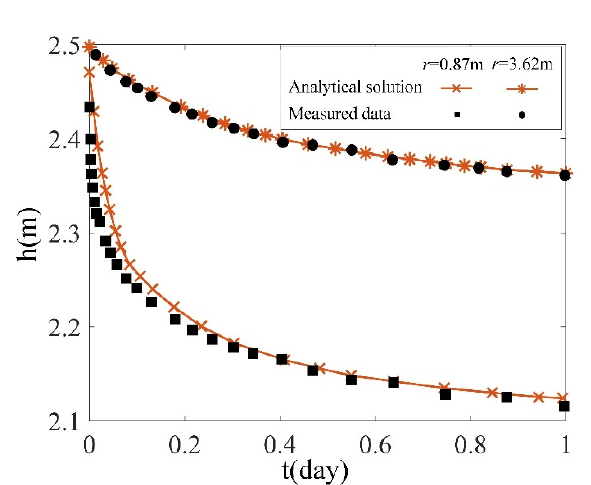
Figure 4. Comparison of the hydraulic head − time curves of the analytical solution and measured data.